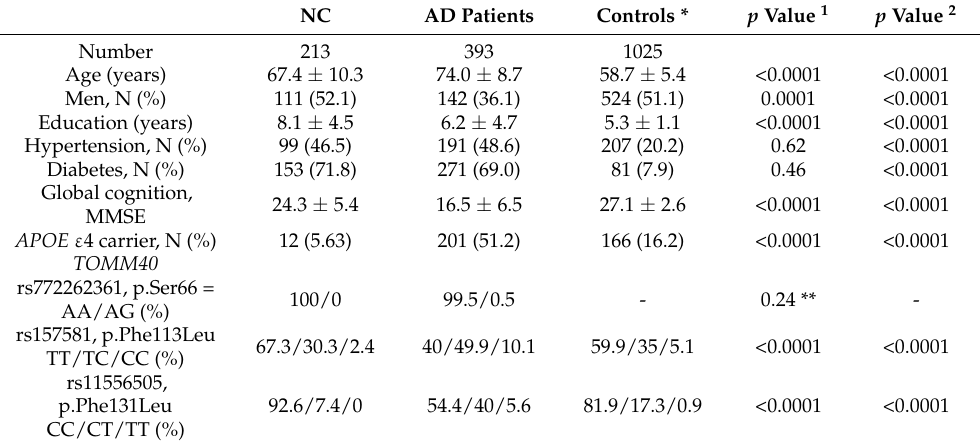
Table 2. Demographics of normal controls (NC), AD patients, and controls from Taiwan